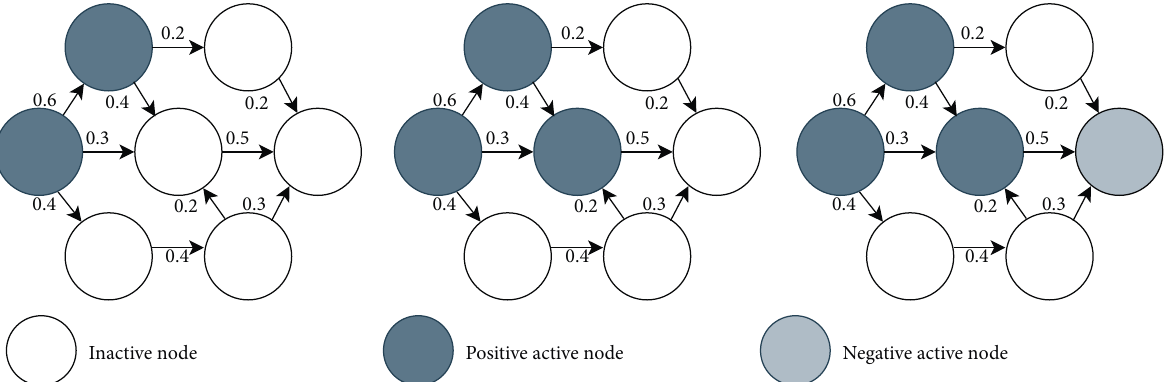
Figure 2: The spread of influence on the BCLT